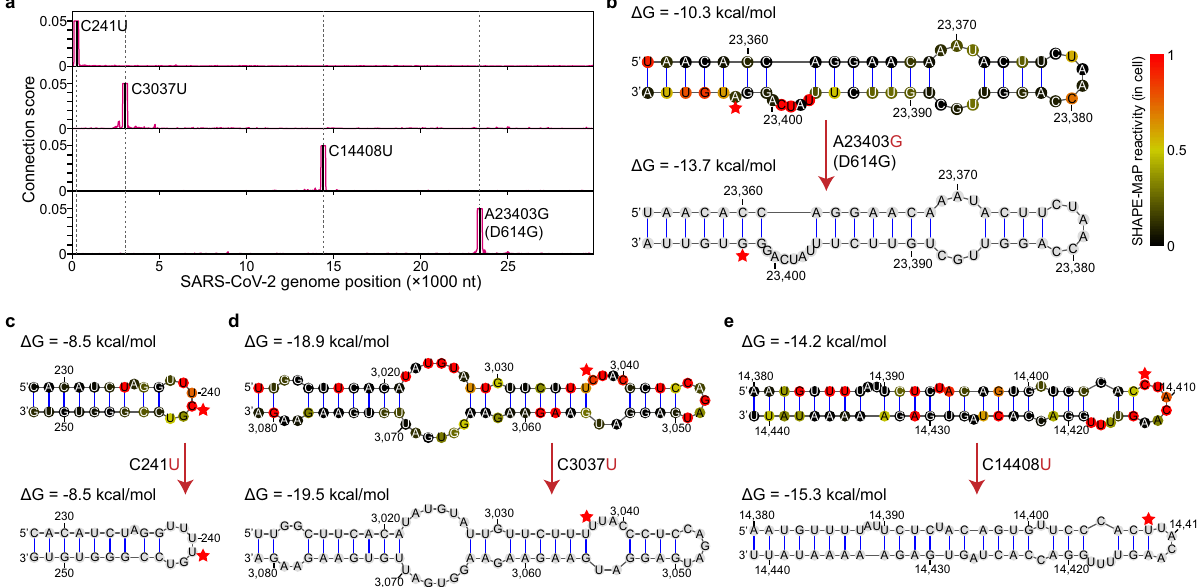
Fig. 6 D614G and the accompanying mutations on structure remodeling. a Line plot showing the point mutation resided regions tend to form local interactions. The C241U, C3037U, C14408U, and A23403G (D614G) mutants are marked as solid lines. b The A-to-G transition (D614G mutant) at 23,403 nt remodels two bulge structures into a single six-nucleotide bulge. Red stars mark the mutated nucleotides. Δ G , free energy. c – e The D614G accompanying mutations have no in fl uence on duplexes except for the C14408U transition ( e ). Structure-guided cleavage of SARS-CoV-2 RNA . RNA cleavage structure may enable potent prevention of SARS-CoV-2 infection. mediated by small interfering RNA (siRNA), antisense oligonu- In order to screen for cleavage-vulnerable regions of the SARS- cleotides, and RNA-targeting CRISPR, has emerged as a ther- CoV-2 RNA genome to develop anti-viral drugs, we system- apeutic modality to restrain viral gene expression and inhibit atically selected 130 single-stranded regions that (i) have at least viruses in host cells 46 . However, it bears emphasis that target 10 consecutive nucleotides and (ii) contain strong conservation RNA cleavage ef fi ciency is strongly affected by duplex among the different SARS-CoV-2 strains we examined (Supple- structures 8,9 . As the in-virion structure revealed by vRIC-seq may mentary Data 5). Next, we synthesized six siRNAs speci fi cally be similar to the SARS-CoV-2 RNA genome con fi guration when targeting single-stranded regions and three siRNAs targeting virions just enter the host cells or at the fi nal assembly stage duplex regions to cleave the SARS-CoV-2 RNA genome, and (Fig. 4a), therefore designing siRNAs based on the in-virion conducted infectivity assays using Vero cells (Fig. 7a). NATURE COMMUNICATIONS| (2021) 12:3917